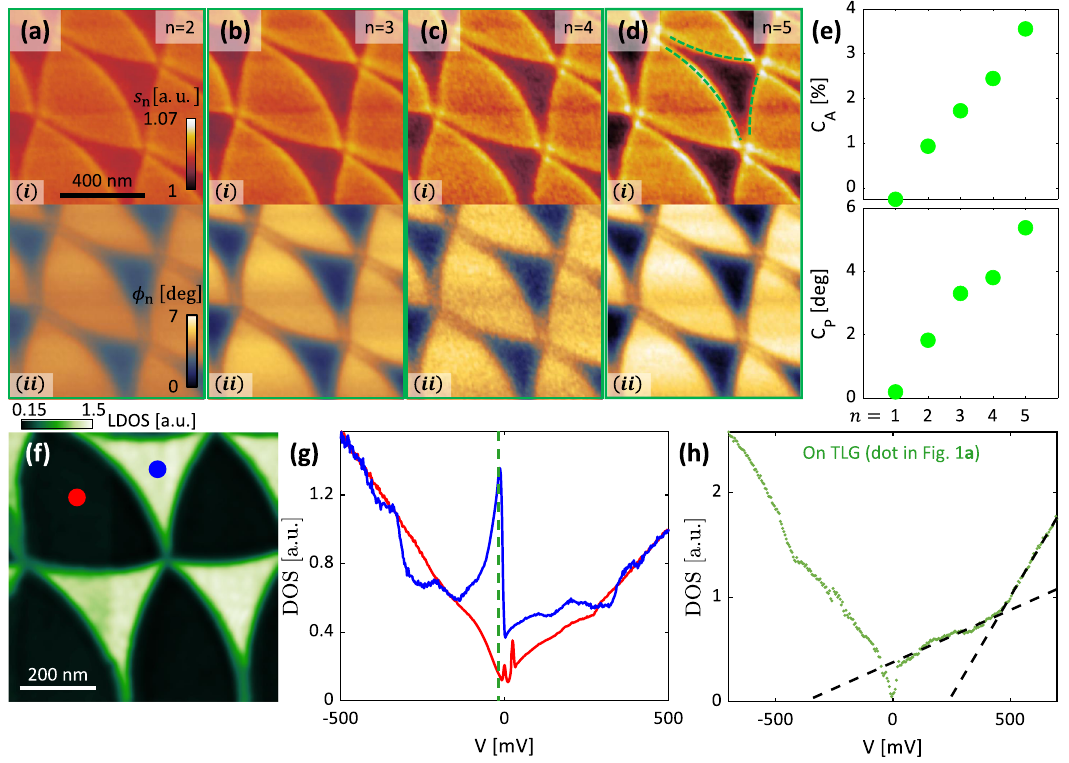
Fig. 2 | Imaging of the TDTG moiré. a – d Mid-IR near- fi eld imaging (over green squareinFig.1a)showingbright(convex)anddark(concave)domains:normalized amplitude ( i ) and phase ( ii ) at different probe demodulation harmonics from 2nd ( a ) to 5th ( d ). The measurement was done at room temperature and a laser fre- quencyof 1000cm − 1 . a – d share a color-barand scale-bar. Dashed arcsin( d ) with a radius of 850 nm highlight the domain shape. e Amplitude (top) and phase (bot- tom) contrasts between the two domains of ( a – d ) as a function of demodulation